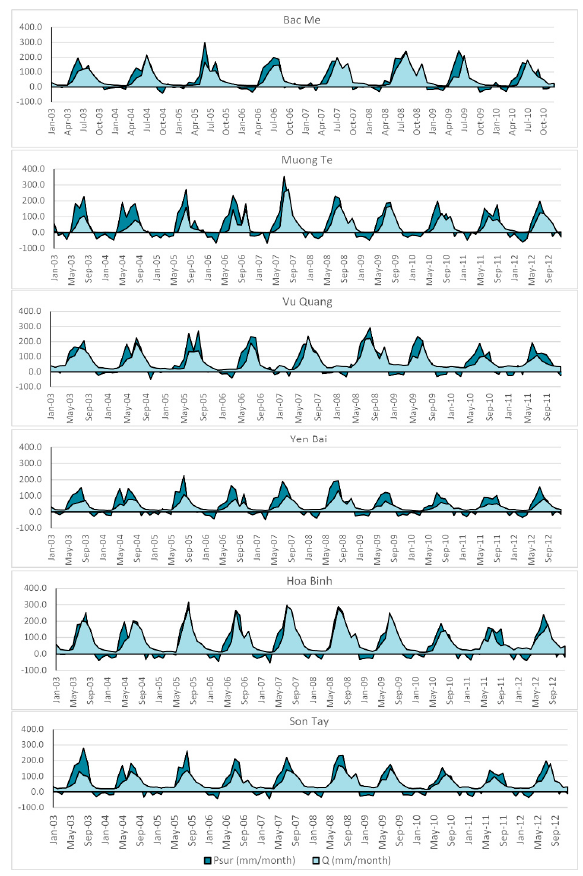
Figure 10. Graphs of upstream rainfall surplus (P sur ) from remote sensing and measured streamflow (Q) for each of the available discharge stations.